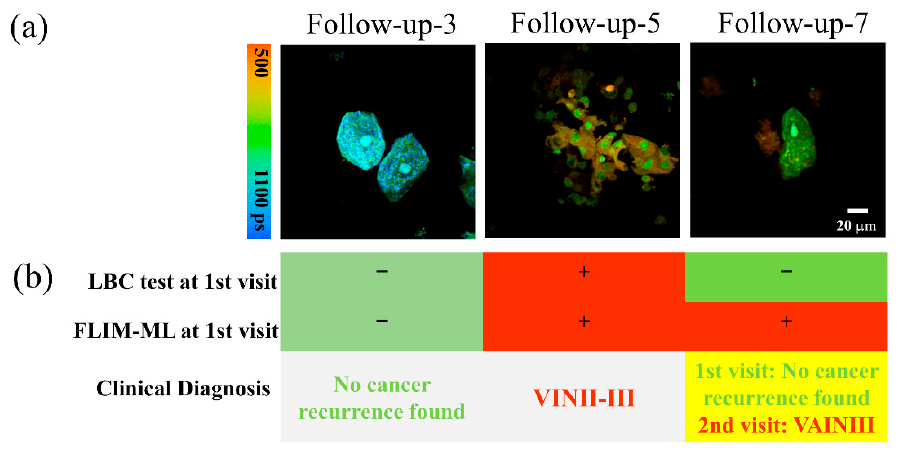
Figure 7. Results of three follow-up patients. ( a ) FLIM t m images of the three patients. LBC test; ( b ) the results of the LBC test and FLIM-ML method and the clinical diagnosis. Follow-up-7 was predicted as high risk by FLIM-ML at the first follow-up visit but was judged normal by the current clinical methods. The cancer recurrence of Follow-up-7 was not clinically found until the second visit eight months